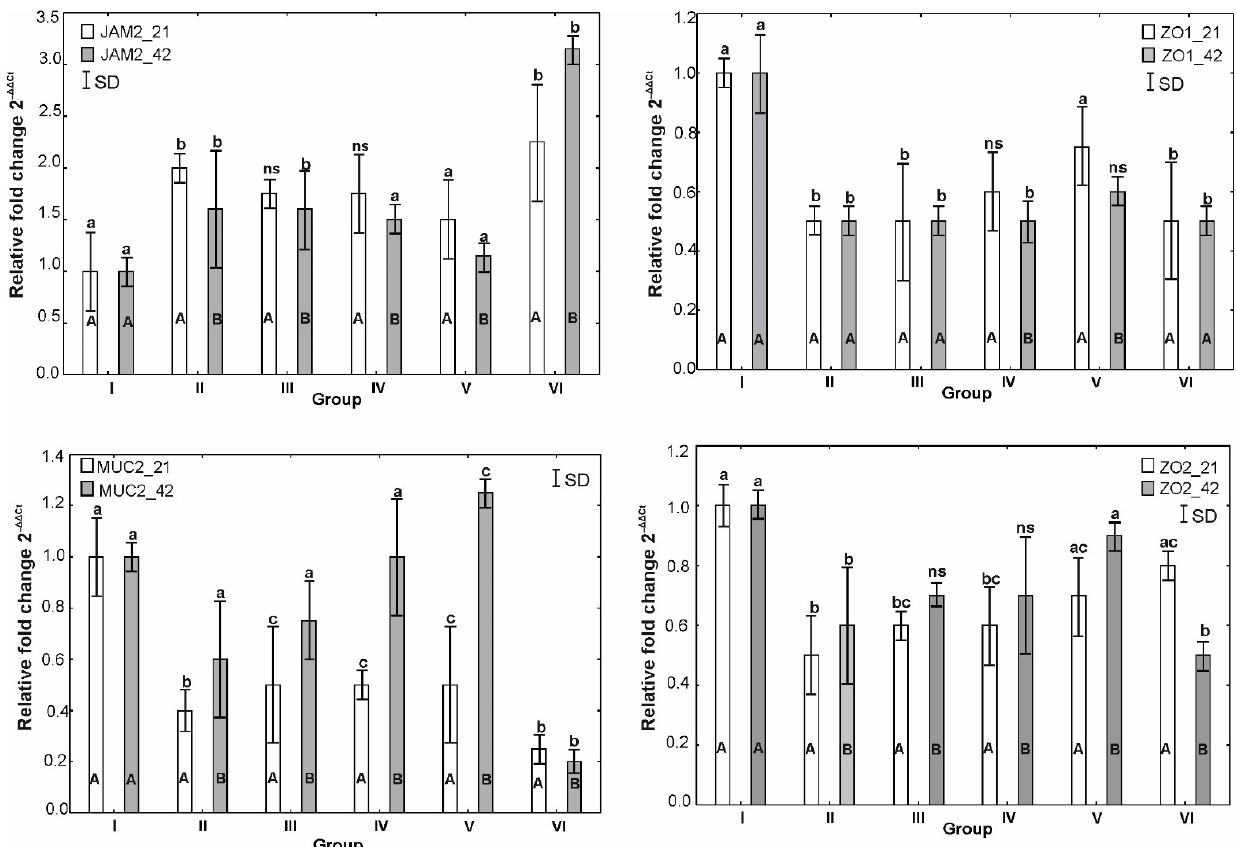
Figure 6. Results of the Kruskal–Wallis one-way ANOVA test (lowercase letters – a, b, c) and the Mann–Whitney U test (uppercase letters – A, B) for 3 JAM2—junctional adhesion molecule 2, MUC2—mucin, ZO1– zonula occludens 1, and ZO2—zonula occludens 2 gene expression in the caecum of chickens at 21 and 42 days of age. Statistical differences ( p ≤ 0.05) are marked with different letters; ns—statistically non–significant differences. Group I (control group)—basal diet; group II—basal diet + 0.5% multi-strain probiotic formulation EM Bokashi ® per tonne of feed + 3% clinoptilolite as a feed additive; group III—basal diet + 0.8% multi-strain probiotic formulation EM Bokashi ® per tonne of feed + 3% clinoptilolite; group IV—basal diet + 0.5% multi-strain probiotic formulation EM Bokashi ® per tonne of feed + 3% clinoptilolite + E. tenella infection; group V—basal diet + 0.8% multi-strain probiotic formulation EM Bokashi ® per tonne of feed + 3% clinoptilolite + E. tenella infection; and group VI—basal diet + E. tenella